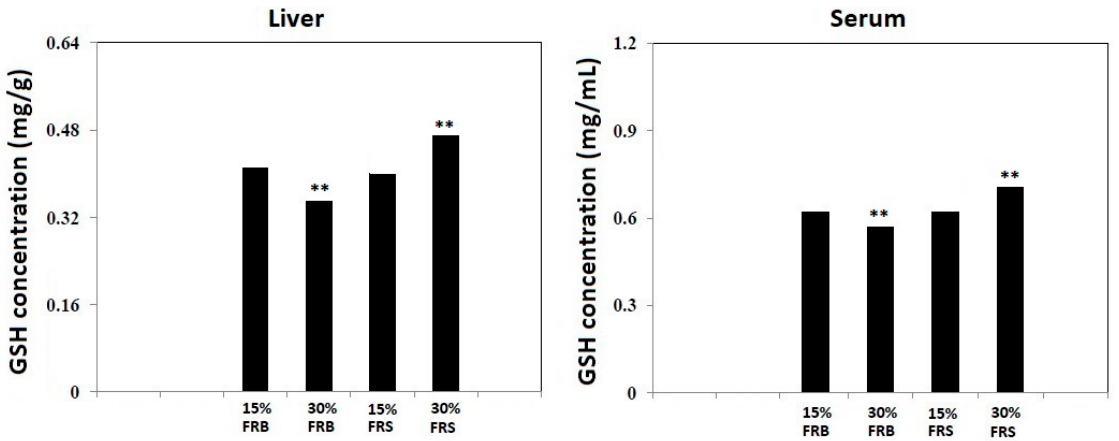
Figure 4. E ff ects of fermented rice bran (FRB) and fermented rice germ and soybean (FRS) on glutathione concentrations in the liver and serum. * Statistical significance at p < 0.05. ** Statistical significance at p <